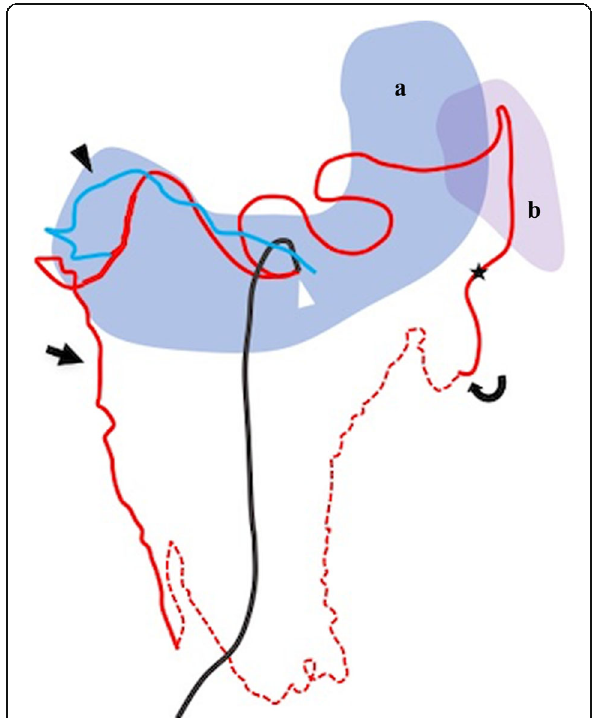
Fig. 3 Schematic image of omental arteries and “ arcades at the greater omentum ” in case 2. The to-be-embolized left omental artery directly communicates with an omental artery branching from the right gastroepiploic artery. Note that proximal embolization at the origin of the left omental artery could cause incomplete hemostasis or rebleeding via collateral circulation from right omental arteries. Black arrow: right omental artery, white arrowhead: the tip of the 4.2 Fr guiding catheter positioned in the celiac artery, black arrowhead: right gastroepiploic artery, black curved arrow: left omental artery, star: the occluded point, red dot line: arcade omental branch between right omental artery and left one, a : stomach, b :